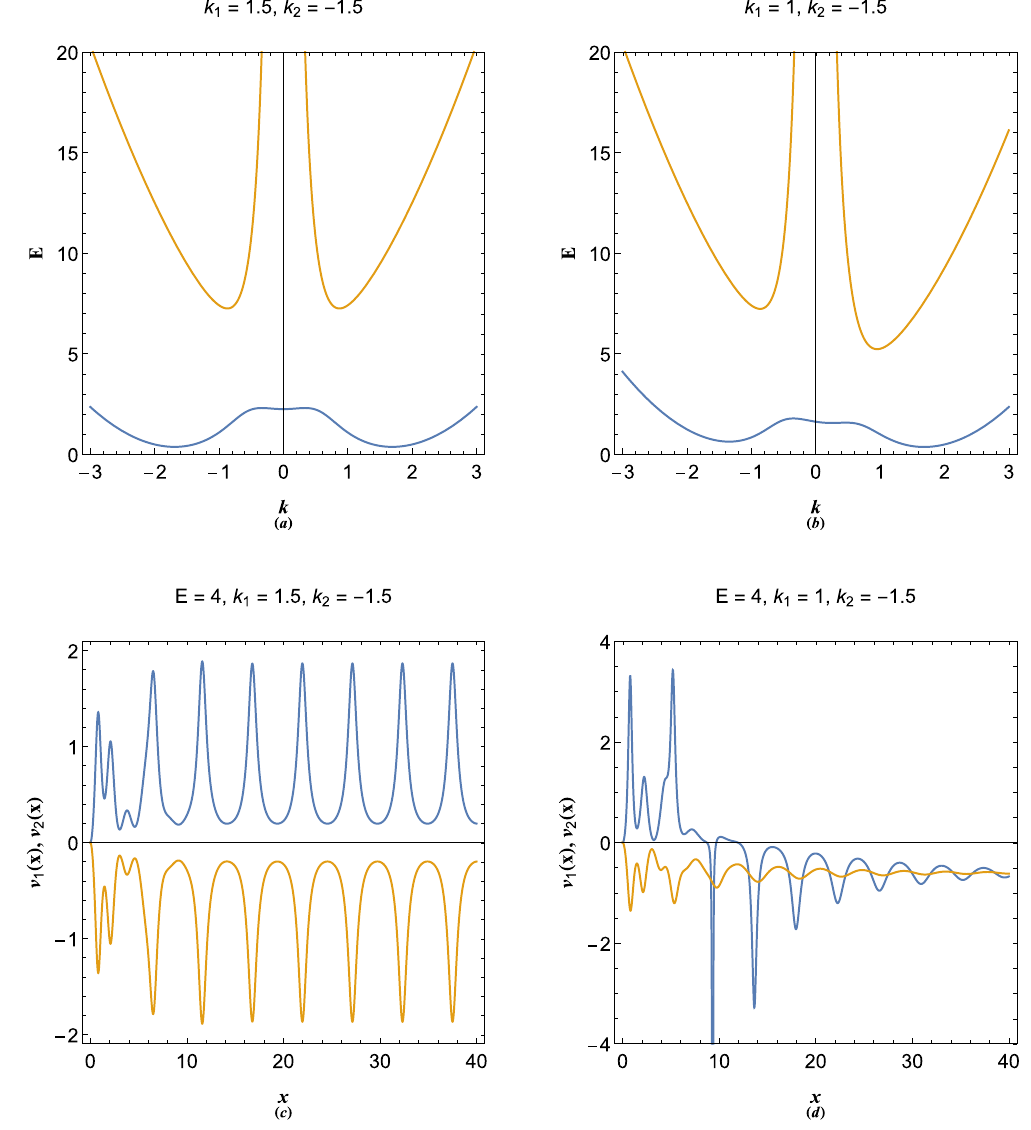
Figure 3. ( a ) Energy band structure of symmetric two-stream plasmon excitations. ( b ) Energy band structure of asymmetric two-stream plasmon excitations. ( c ) Quasiparticle velocity of two-stream excitations in symmetric band gap. ( d ) Quasiparticle velocity of two-stream excitations in asymmetric band gap showing the phase mixing effect due to mode coupling of the energy